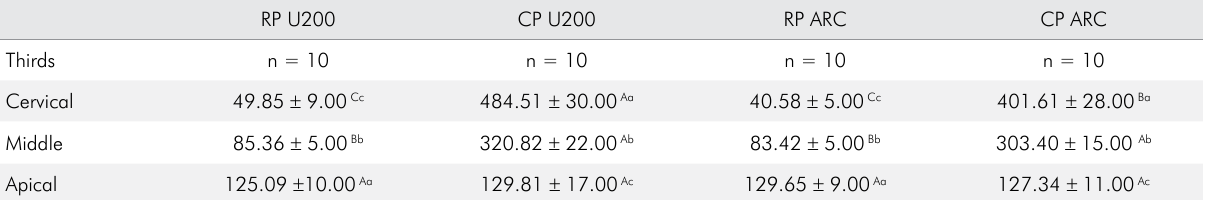
Table 2. Resin cement thickness means (µm) and standard-deviations at cervical, middle and apical thirds using relined fiberglass posts (RP) or conventional fiberglass posts (CP) luted with RelyX U200 (U200) or RelyX ARC (ARC). RP